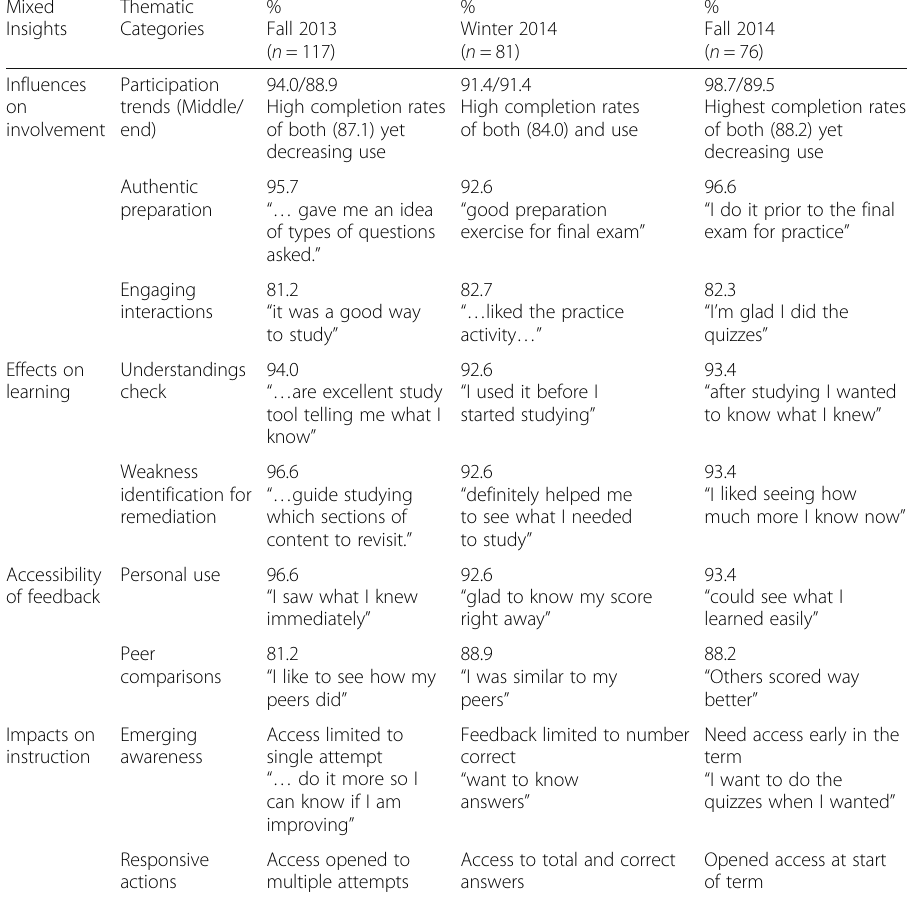
Table 3 Practice quizzes joint display Mixed